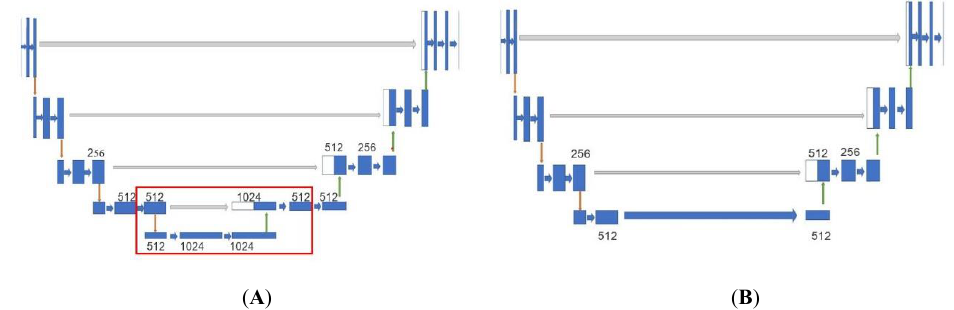
Figure 3. Part structures of U-Net and depth estimation subnetwork. ( A ) U-Net; ( B ) Depth estimation subnetwork of MonoDA.